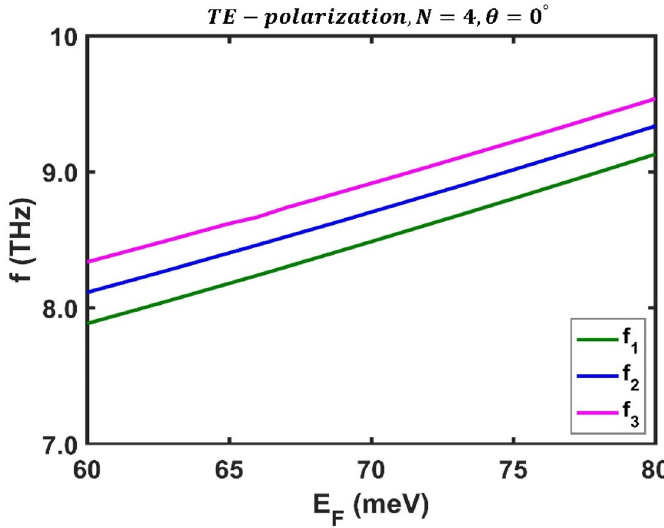
Figure 4. Variation of central frequency of all three the optical channels’ in terms of Fermi energy for TE polarization state under normal incidence in a third-order F-1D PhC structure with N = 4 . The central frequencies of all three optical channels shown in green, blue and magenta colors and ranges from ( f